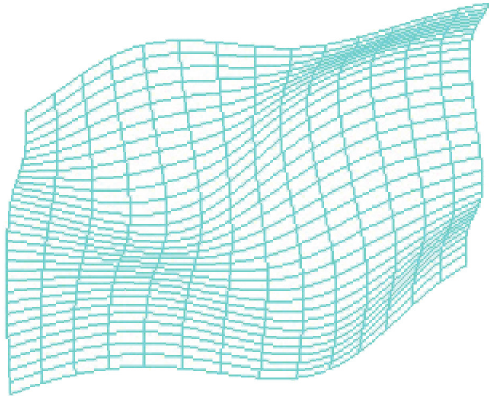
Figure 6: The surface’s control grid.